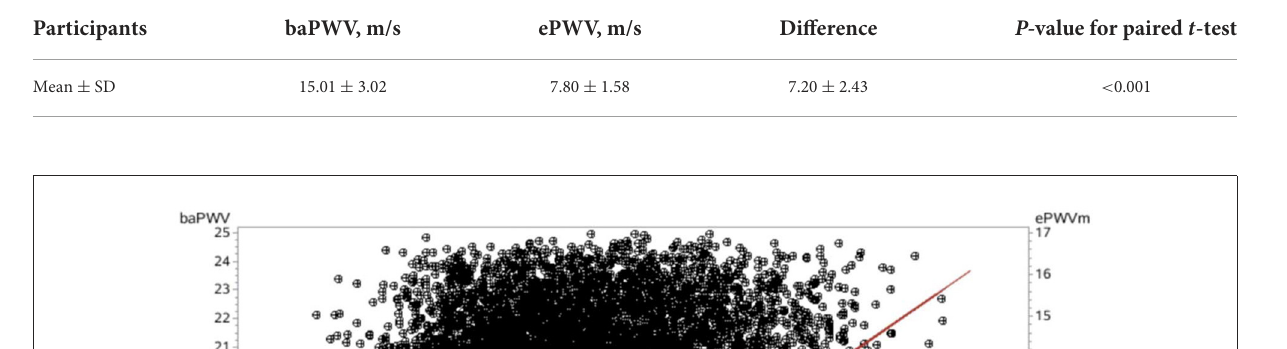
TABLE 4 Comparison between the baPWV and the ePWV.